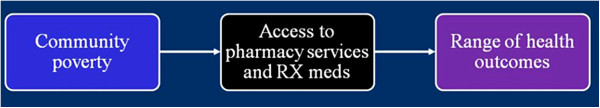
Logic Model. Logic model of the relationship between poverty and access to medications.